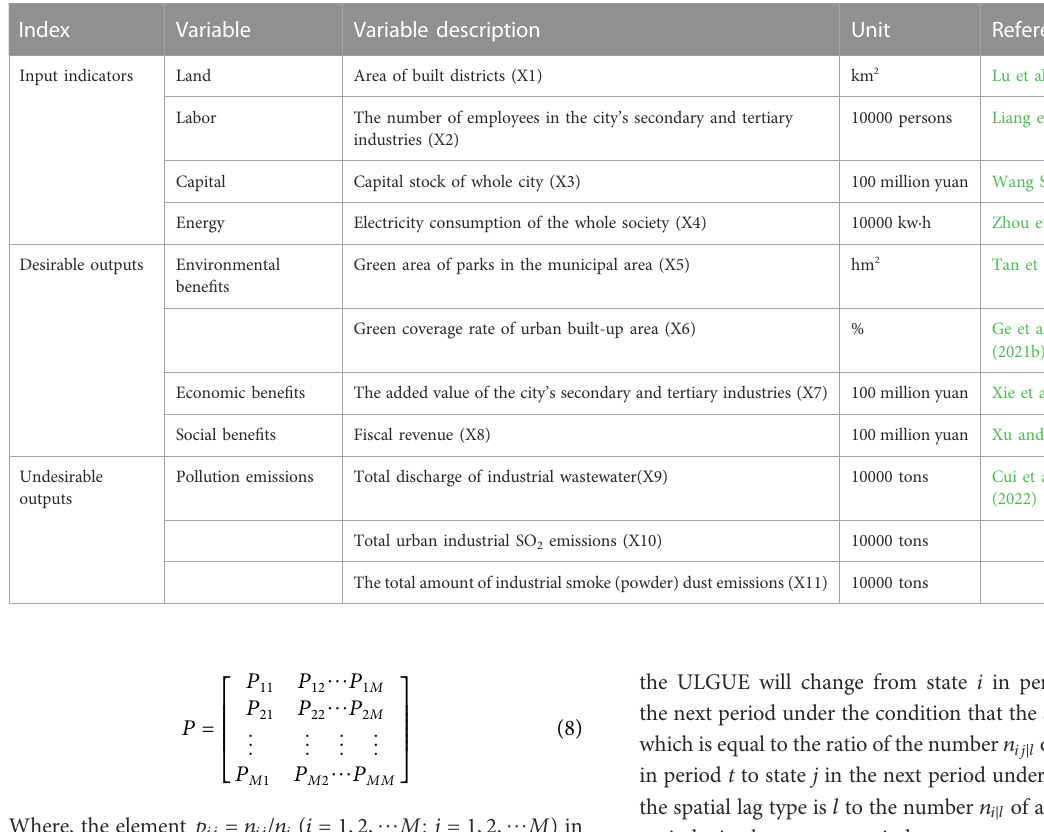
TABLE 1 De fi nitions and measurements of